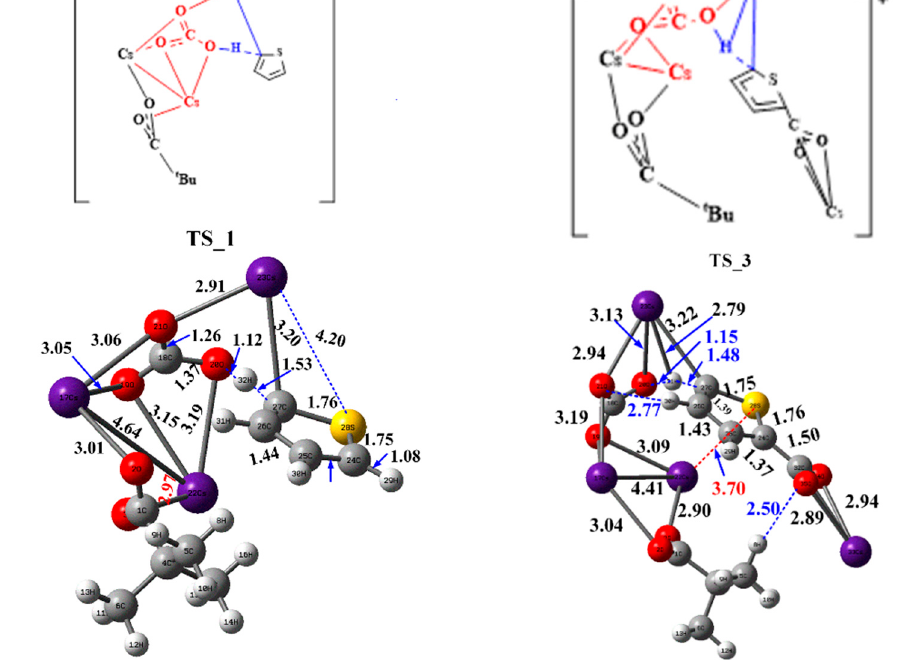
Figure 3. The transition structure for CsOPiv–Cs 2 CO 3 system: ( a ) TS_1 and ( b ) TS_3. Aiming to precisely disclose the origin of the activation energy barrier in this carboxylate- assisted, carbonate-promoted C–H carboxylation reaction process, the distortion/interaction– activation strain analysis [36] along the entire reaction coordinate is employed. Figure 4 shows the results of activation strain analyses in the proton abstraction steps for the bare and carboxylate-assisted Cs 2 CO 3 systems. As discovered from Figure 4a, these two alternative additive possibilities have the similar strain energy term along the reaction coordinate, and both are greater than that of the bare Cs 2 CO 3 process. After the transition state position of the bare Cs 2 CO 3 process, the distortion energy of the cesium acetate alternative exceeds that of the cesium pivalate process. The interaction energy between this carboxylate-carbonate system and thiophene in the pivalate-assisted process is higher than that of the other two possibilities, while the interaction energy term in the cesium acetate process is the lowest. Therefore, the higher activation energy barrier in the acetate-assisted thiophene proton abstraction step derives from the combination effect of the more destabilizing strain energy term and the least stabilizing interaction energy term, which will make the reaction more endothermic and results in the shifting of the transition state to a later stage and the product side. However, the origin of the larger free energy barrier in the pivalate pathway results from the stronger strain energy term with the help of the stabilizing factor. Figure 4b indicates that the interaction energy terms in these two carboxylate-assisted systems are weaker than that of the bare Cs 2 CO 3 pathway. There is little difference in the interaction energy curve between the pivalate and acetate processes, but it is still larger for the pivalate system. As the reaction proceeds, the distortion energy in the bare carbonate process is increases and gradually exceeds that of the carboxylate-assisted systems. Hence, the formation of the later stage transition structure for these two carboxylate pathways is caused by the less stabilizing factor with the softer strain term. The higher activation energy barrier in the acetate-assisted monocarboxylate proton abstraction step derives from the combination effect of the more destabilizing strain energy term and the least stabilizing interaction energy term when compared with that of the pivalate-assisted